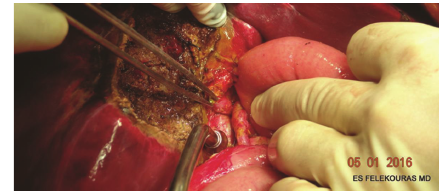
Figure 5: Completion of the